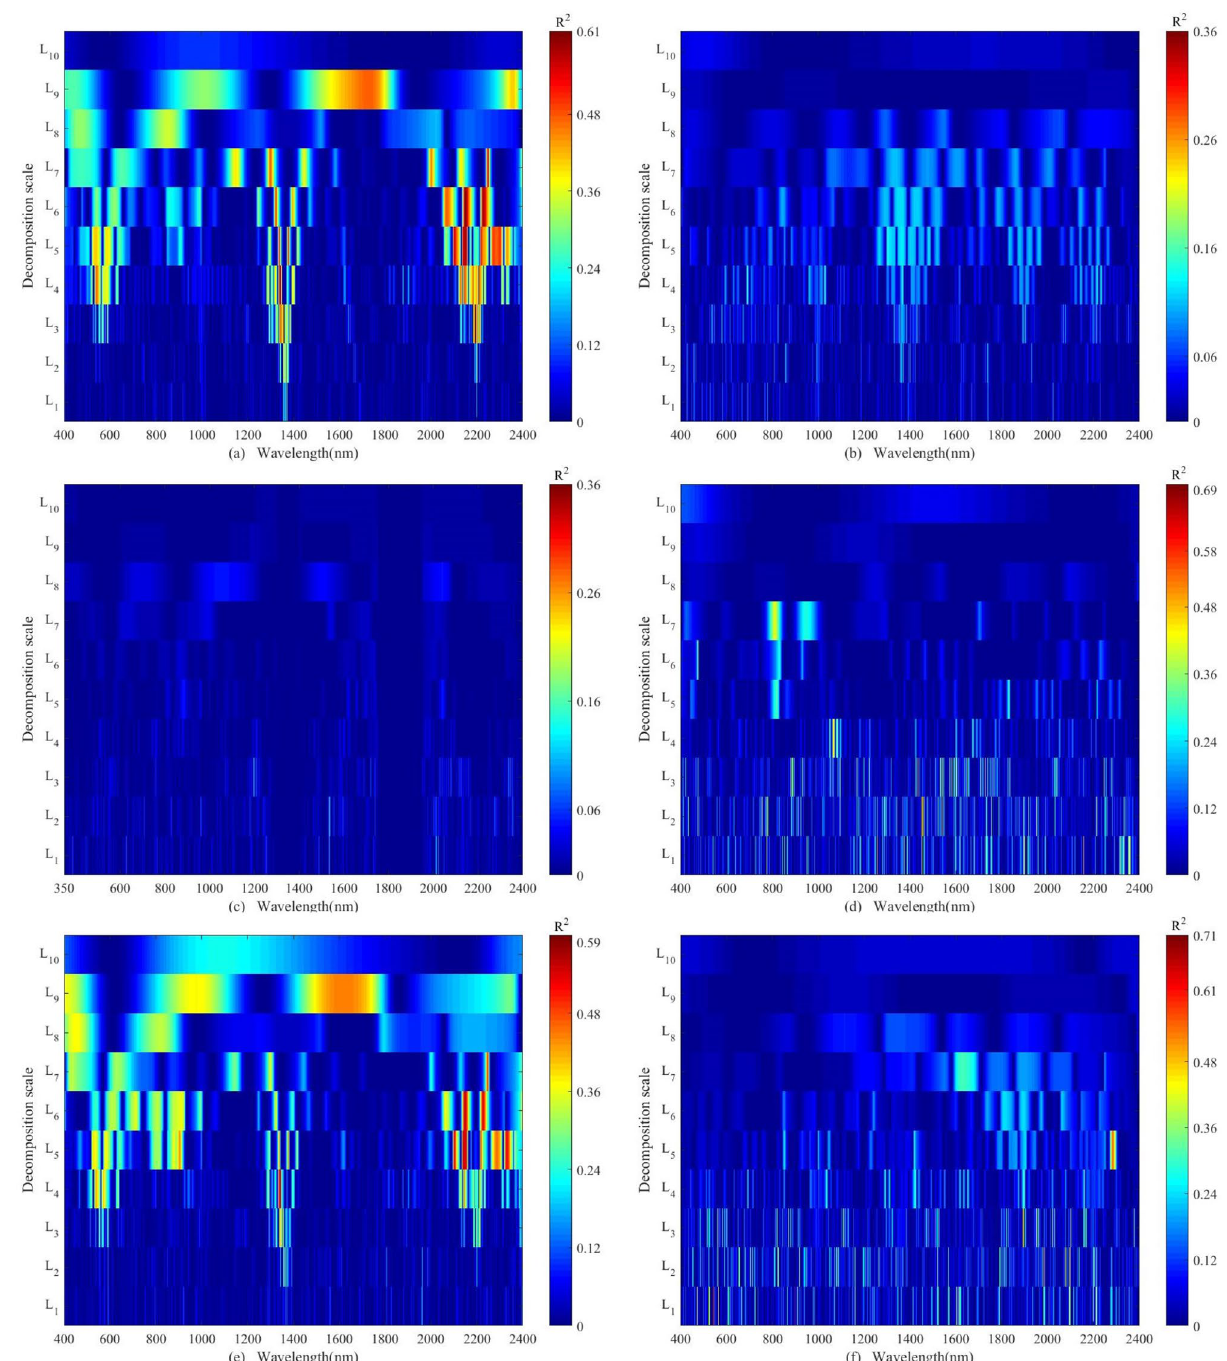
Figure 5. Correlation of determination (R 2 , P < 0.01) between Zn concentrations corrected by natural logarithmic transformation and spectral reflectance transformed by CWT under six conditions of soil samples, including ( a ):lab-based processed, ( b ): lab-based processed, ( c ): in-situ, ( d ): clean group (Zn ≤ 48.6 mg kg −1 ), ( e ): low pollution group (48.6 ≤ Zn ≤ 97.2 mg kg −1 ), and ( f ): moderate pollution group (97.2 ≤ Zn ≤ 145.8 mg kg −1 ). (Note: The spectral reflectance was measured after processing at the laboratory for the clean group, low pollution group, and moderate pollution group. L 1 –L 10 denotes the reconstructed spectral reflectance curves based on CWT at decomposition scales of